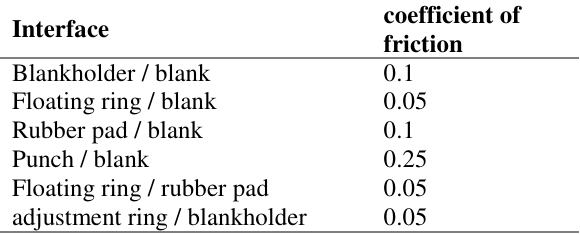
Fig. 7. (a) FE model of SS 304 blank (b) FE model of flexible pad.